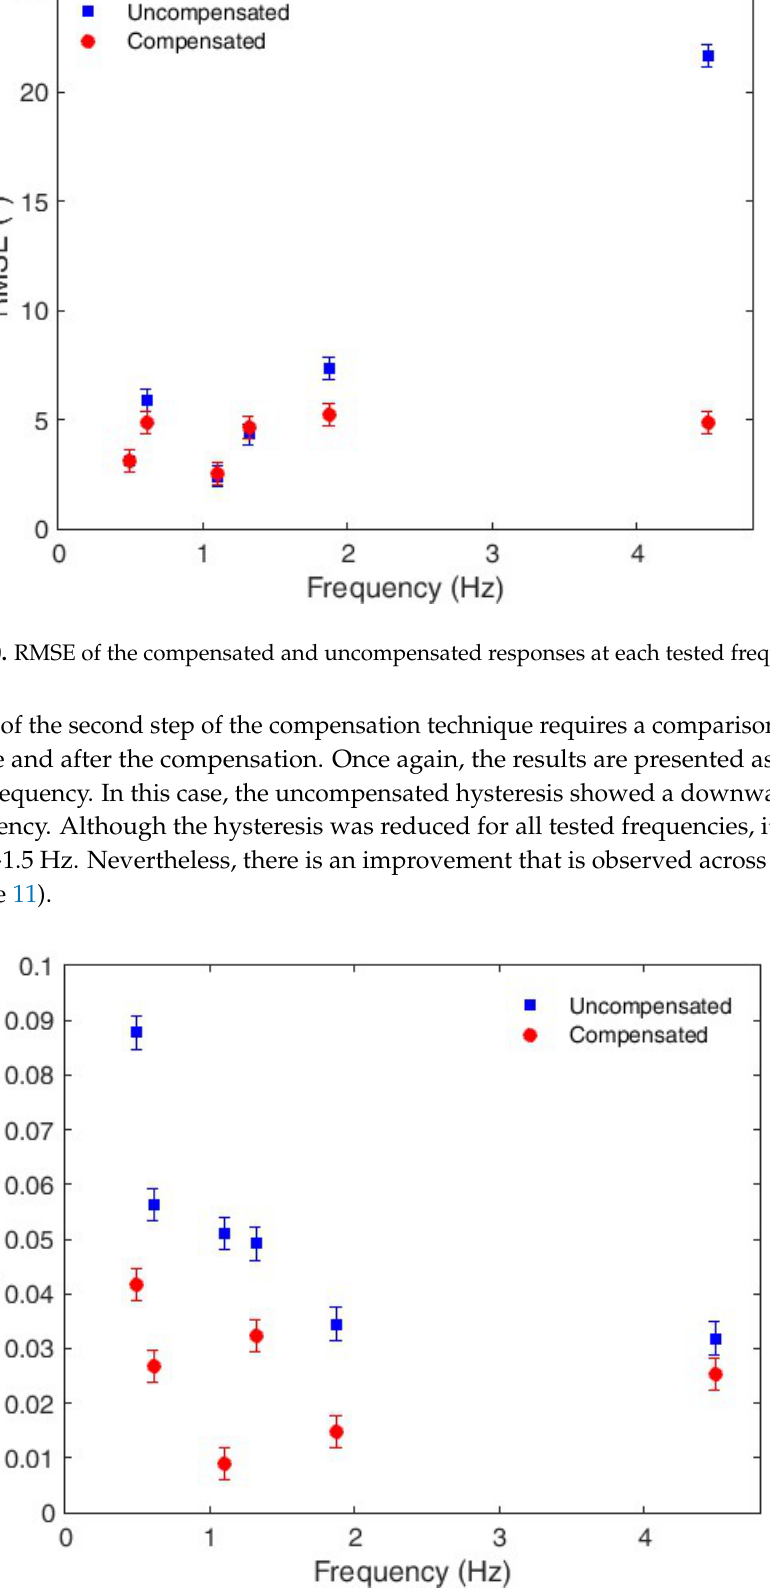
Figure 11. Hysteresis of the compensated and uncompensated responses at each tested frequency.